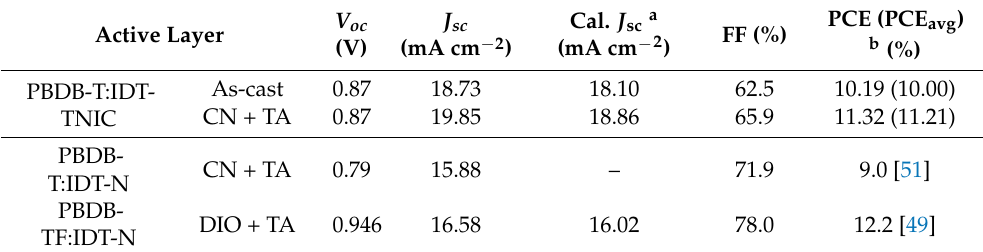
Figure 2. ( a ) J-V plots of the PBDT-T:IDT-TNIC-based OSCs (1:1, w/w ) with 0.75% CN additive, and a TA treatment at 150 °C for 5 min under an illumination of AM 1.5 G, 100 mW cm − 2 . ( b ) EQE curves of the corresponding OSCs. Table 1. Photovoltaic parameters of the PBDT-T: IDT-TNIC-based OSCs (1:1, w/w ) with 0.75% CN additive, and a TA treatment at 150 ◦ C for 5 min under an illumination of AM 1.5G, 100 mW cm − 2